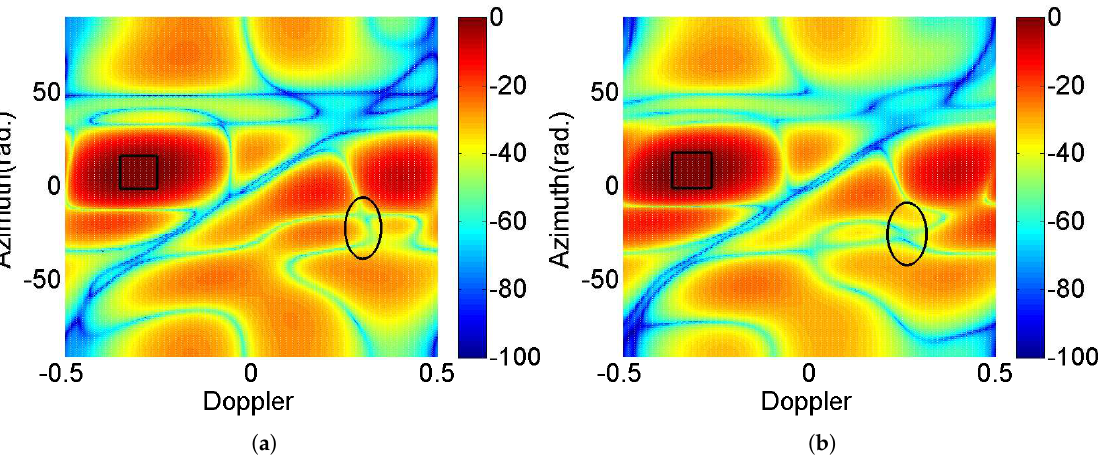
Figure 8. Doppler-azimuth plane of CAF for iteration number k 2 = { 10,50 } for different formulations.